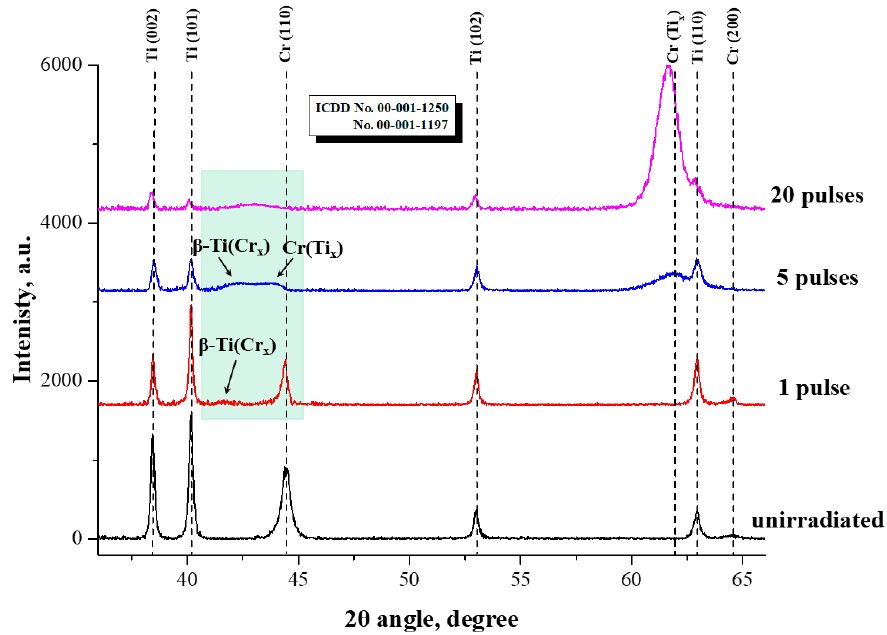
Figure 8. XRD pa tt erns of Cr/Ti system samples before and after IPIB treatment. Figure 8. XRD patterns of Cr/Ti system samples before and after IPIB